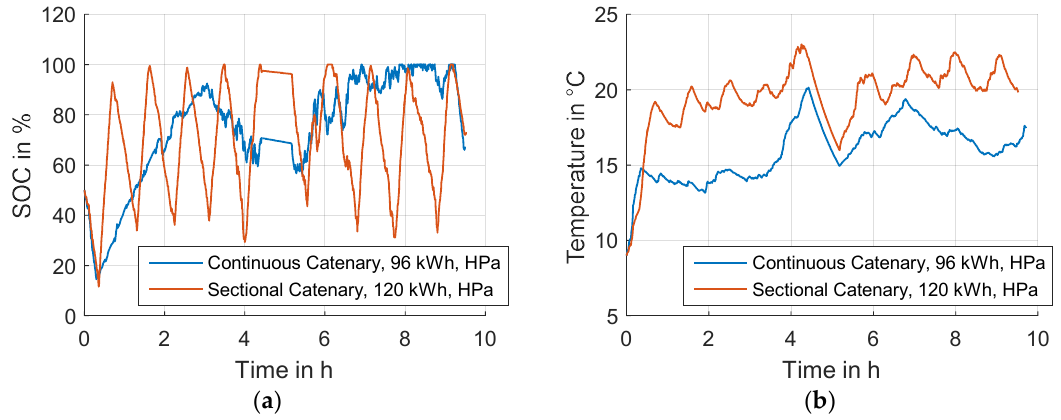
Figure 9. ( a ) State of charge (SOC) and ( b ) temperature of the traction battery during the daily transportation scenario for the overhead catenary trucks using the continuous and sectional catenary configurations.